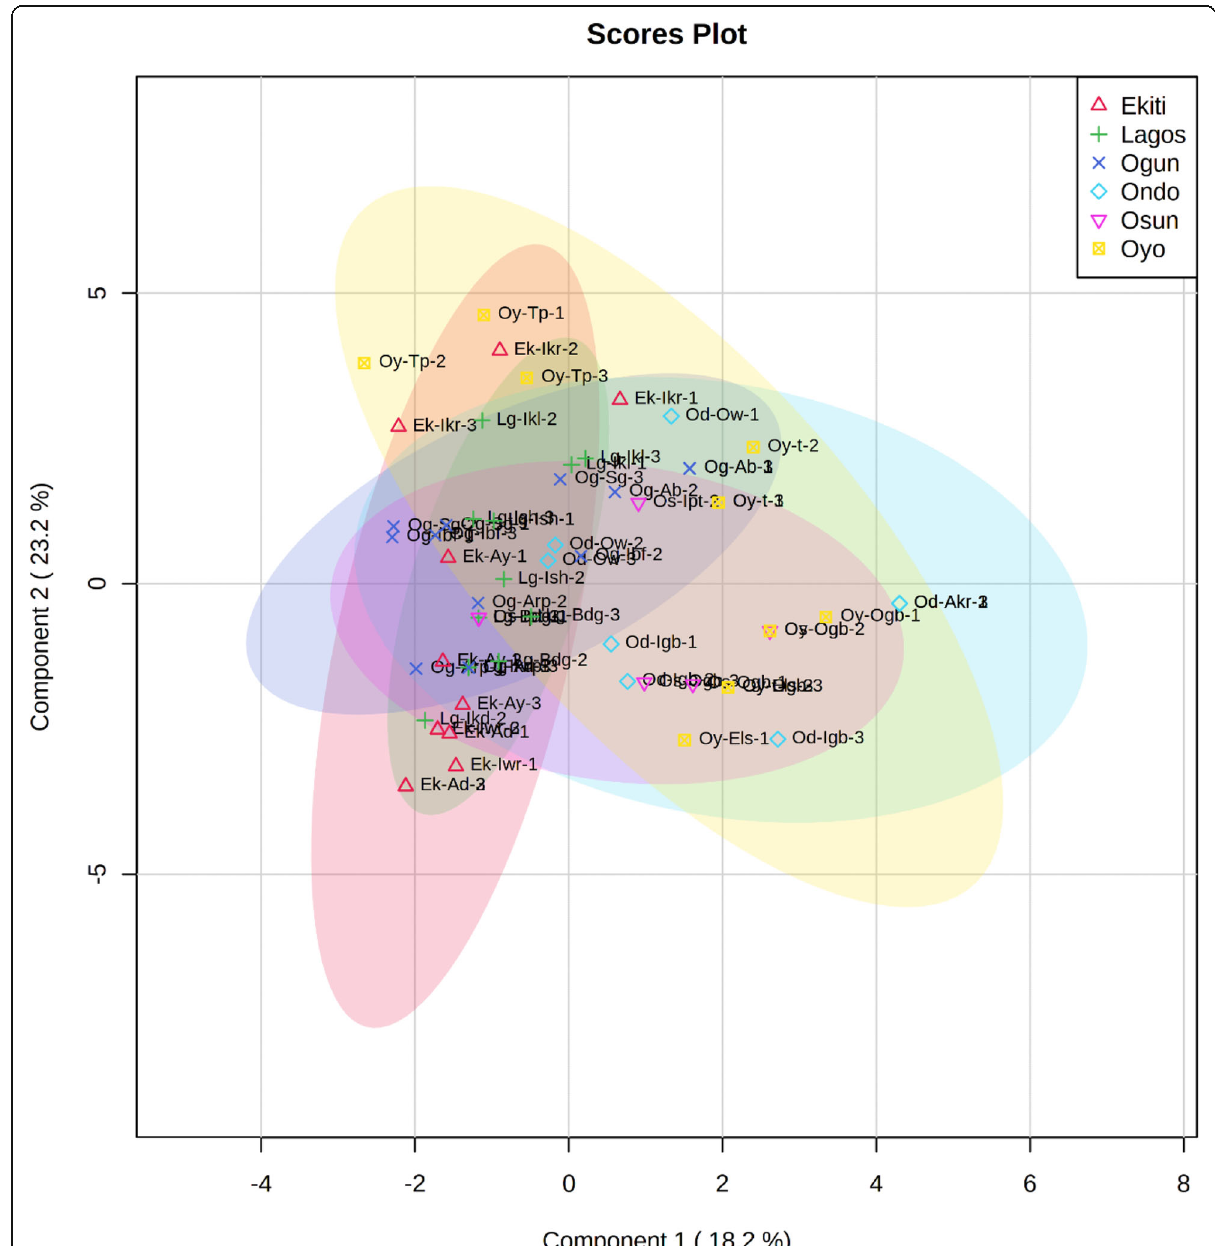
Fig. 9 PLS-DA plot of all the results from different locations. The groups from Ekiti are in red, Lagos in green, Ogun in deep blue, Ondo in light blue, Osun in fuchsia pink and Oyo in